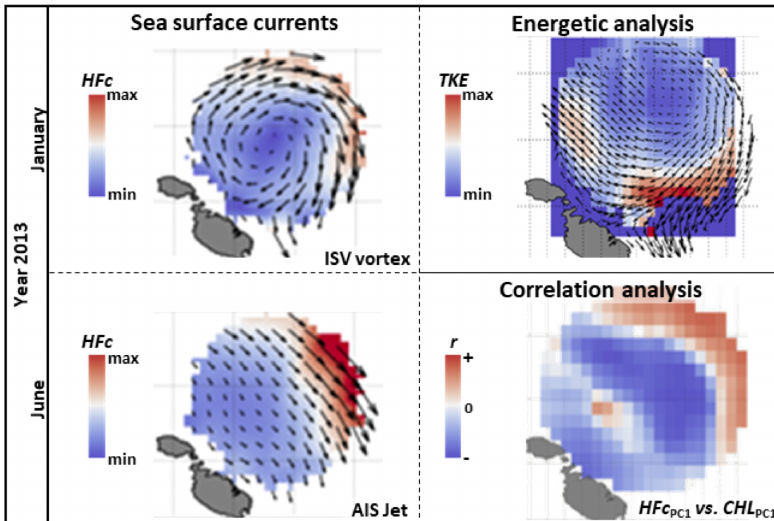
Figure 16. Map of the Malta–Sicily Channel showing the monthly averaged HFR sea surface currents for January and June 2013 (top left and bottom left panels, respectively) as well as the spatial distribution of the total kinetic energy (top right panel) and the correlation coefficient between the first PC of both HFR and Chl a (bottom right panel). Original from Capodici et al. (2018), graphical abstract.